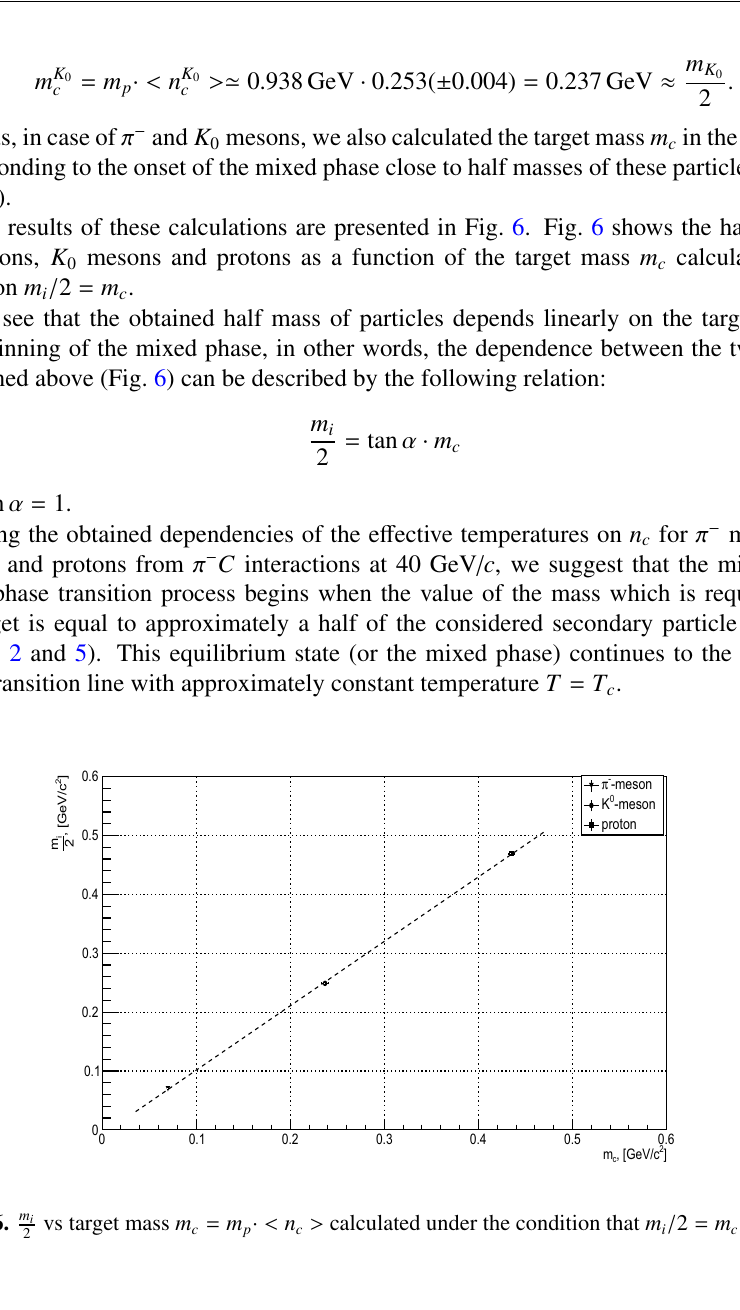
4 Determination of the particle emission region size r ( n c ) , volume V ( n (cid:3) ( n c ) and energy density c ) at breaking